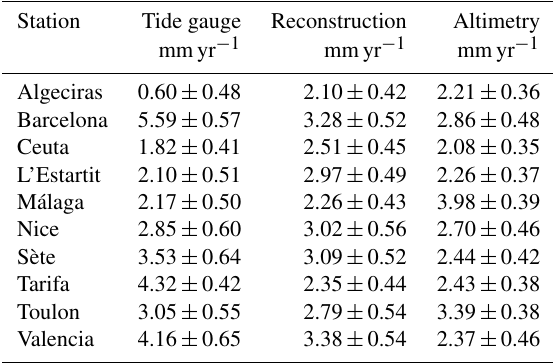
Table 3. Trends of the tide gauge, reconstructions, and altimetry se- ries for the period common to the three datasets (1993–2019), with the standard deviations of the linear regression. Only the stations whose series are at least 80% complete have been included.